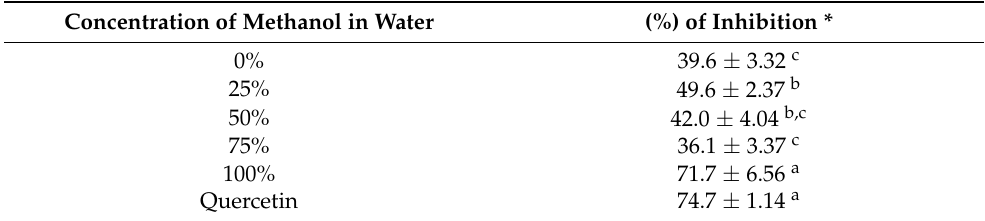
* The values represent mean + SD, n = 4. The values that do not share the same letter are significantly different with p -value < 0.05. Values represent with different superscripts are significantly different, as measured by Tukey’s comparison